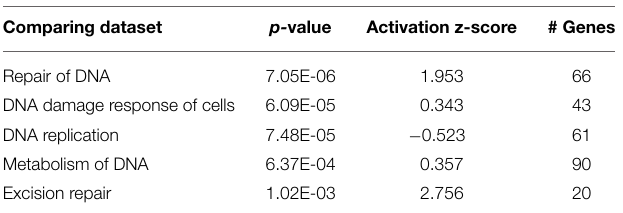
TABLE 3 | Comparison of the hair cell dataset with known expression changes in genes associated with the DNA repair